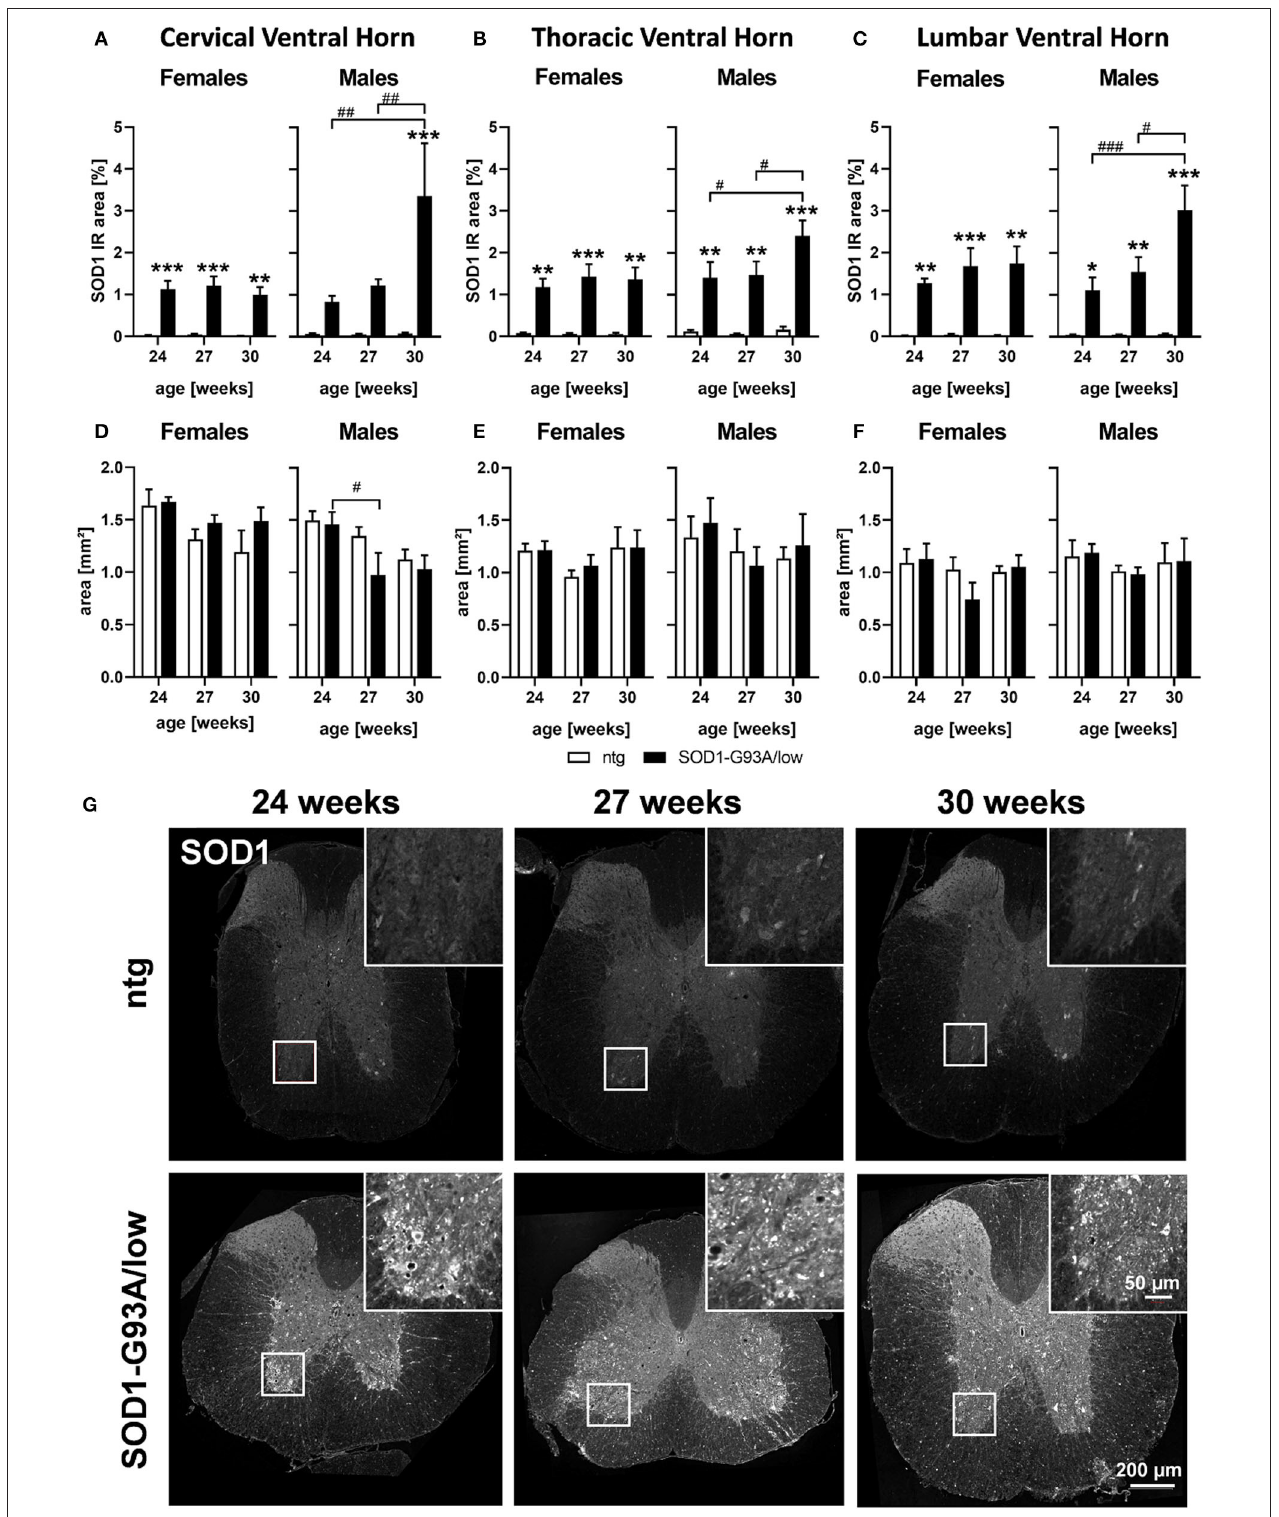
FIGURE 1 | SOD1 protein expression and region size in the spinal cord of 24–30 weeks old SOD1-G93A/low mice. Female and male 24, 27, and 30 weeks old SOD1-G93A/low mice were evaluated for SOD1 expression (A–C) and ventral horn region size (D–F) in the cervical (A,D) , thoracic (B,E) , and lumbar (C,F) ventral horn compared to ntg littermates. Two-way ANOVA with Tukey’s and Sidak’s multiple comparison post hoc test; n = 4 per group. Mean + SEM. * / # p < 0.05, ** / ## p < 0.01, *** / ### p < 0.001. *Differences between genotypes; # differences between age groups. (G) Representative images of SOD1 labeling in the thoracic spinal cord of 24, 27, and 30 weeks old male SOD1-G93A/low mice compared to ntg littermates.